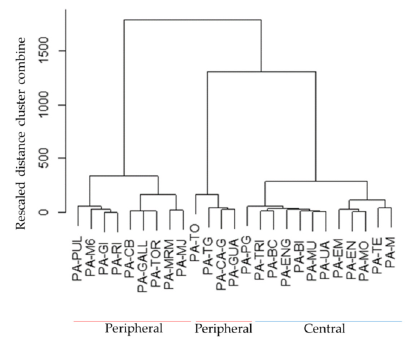
Figure 3. Hierarchical cluster analysis (HCA) of the 25 populations of Pinus arizonica forest communi- ties in the Sierra Madre Occidental. The populations (sampling points) are represented with their abbreviated